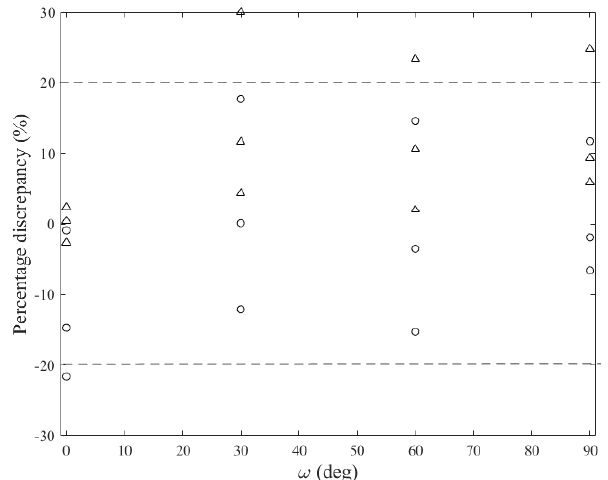
Figure 6. Average FFM predictions: Percentage discrepancy with respect to experimental data referring to blunt V-notched structures made of Al 7075-T6 (circles), and made of Al 6061-T6 (triangles).